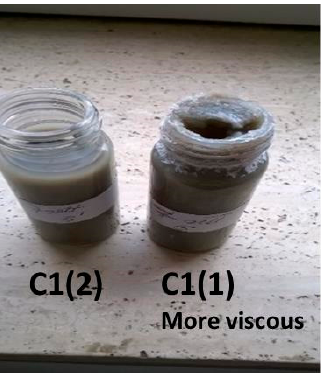
Figure 1. Sample with composition C1(1) in comparison to the sample with composition C1(2).